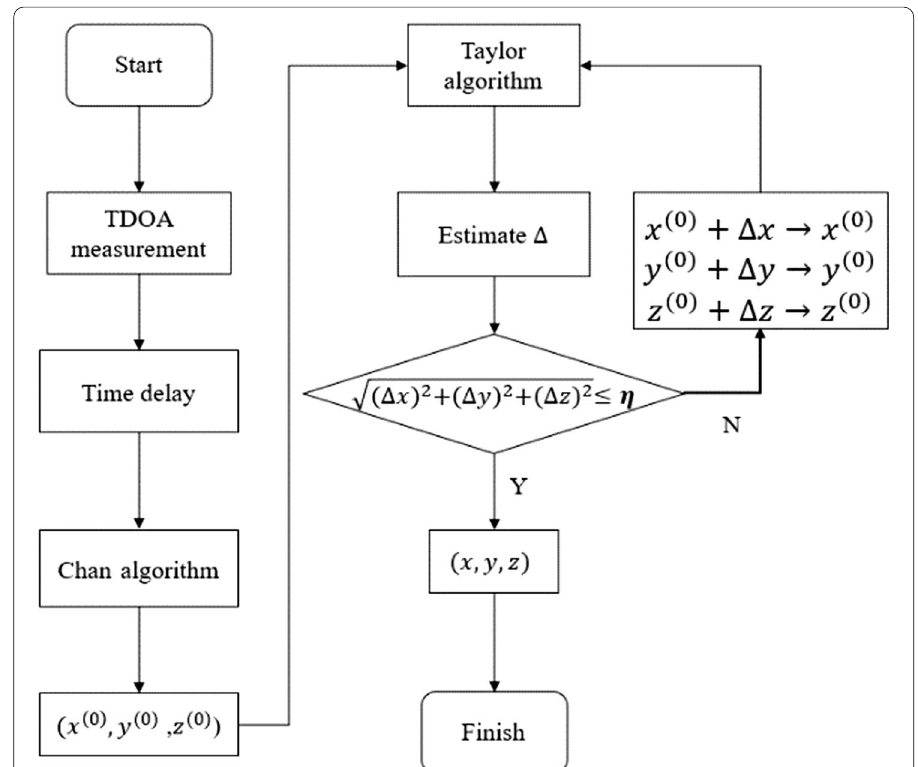
Fig. 3 Flowchart of the proposed Chan–Taylor hybrid